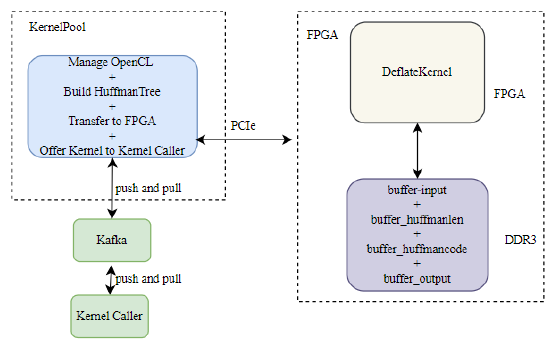
Fig. 2. Architecture diagram of the hardware compression acceleration layer.